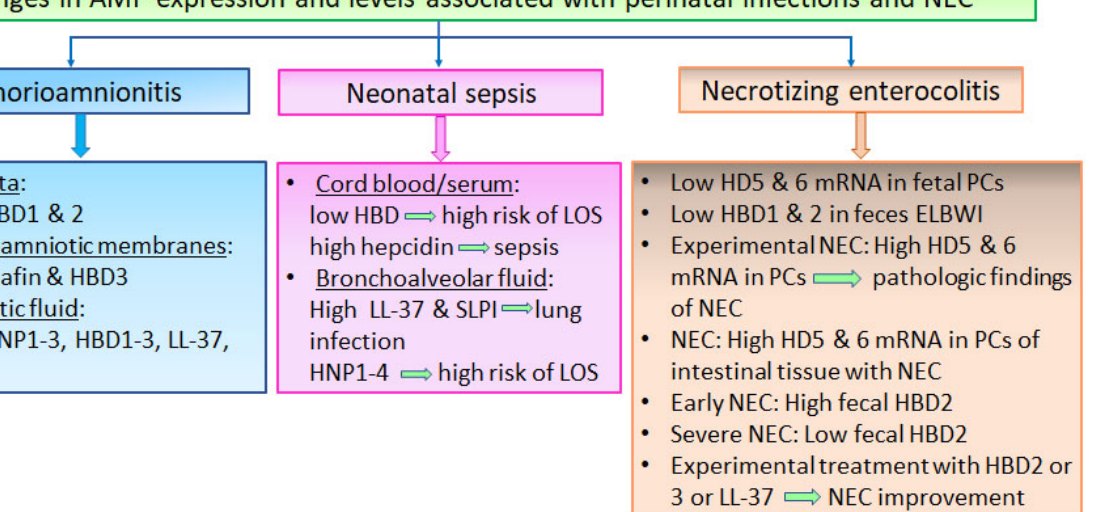
Figure 4. Schematic illustration of published data regarding changes in AMP expression and levels associated with chorioamnionitis, neonatal infections, and necrotizing enterocolitis (NEC). Abbre- viations: ELBWI, extremely-low-birth-weight infants; LOS, late onset sepsis; PCs, Paneth cells